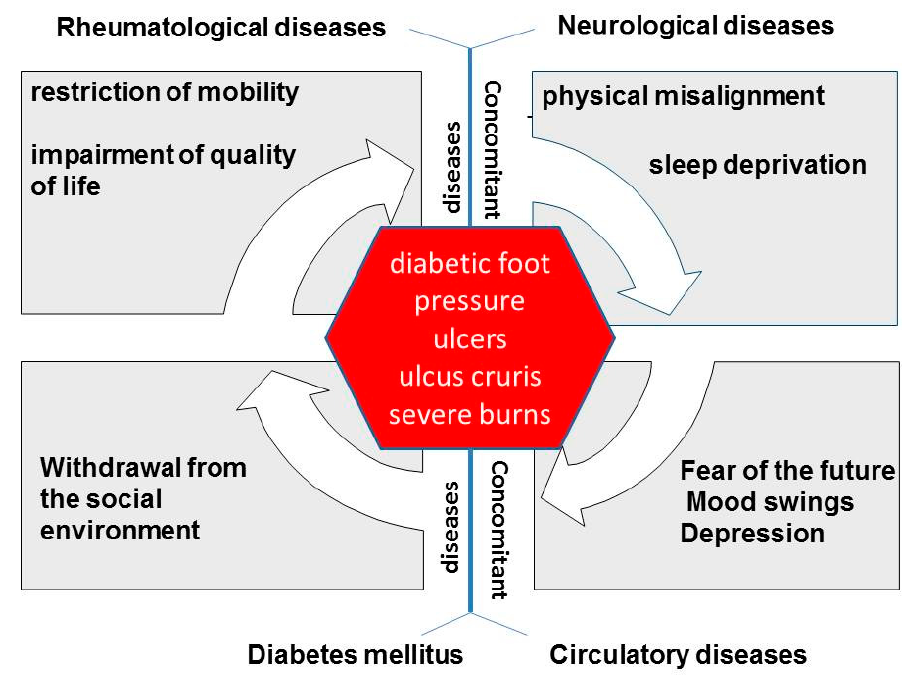
Figure 5. Vicious circle-wound and accompanying diseases.